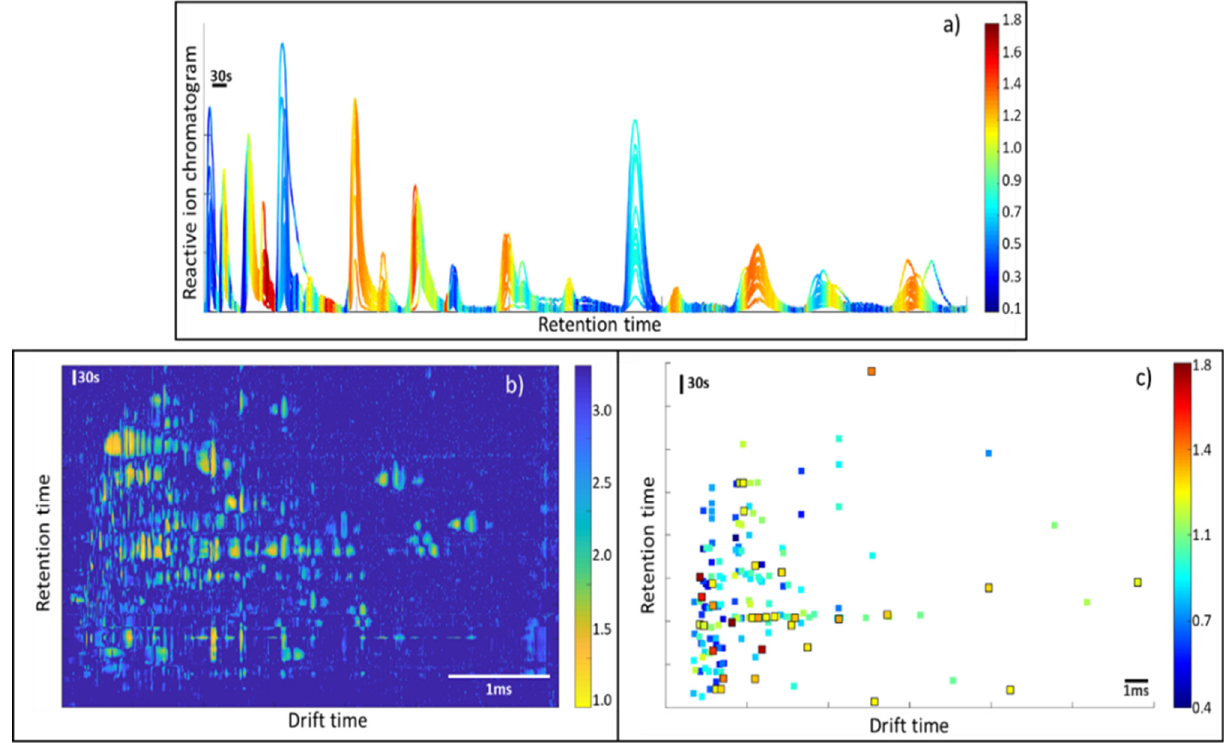
Figure 5. ( a ) VIPs for the reactive ion chromatogram, ( b ) VIP distribution for the full matrix (only values over VIP = 1 displayed), ( c ) VIP values for the detected peaks.